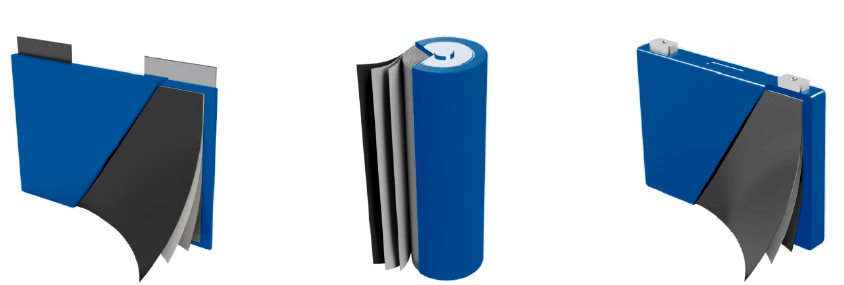
Figure 1. Typical Cell Types for Lithium Ion Batteries. From left to right: Pouch Cell, Cylindrical Cell and Prismatic Cell.